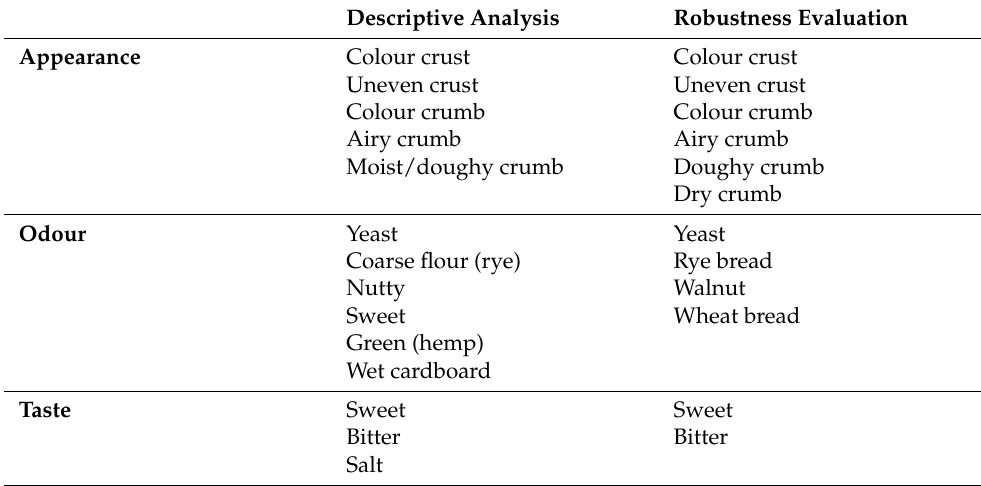
Table 2. Sensory descriptors used in the descriptive analysis of the ten buns and the robustness